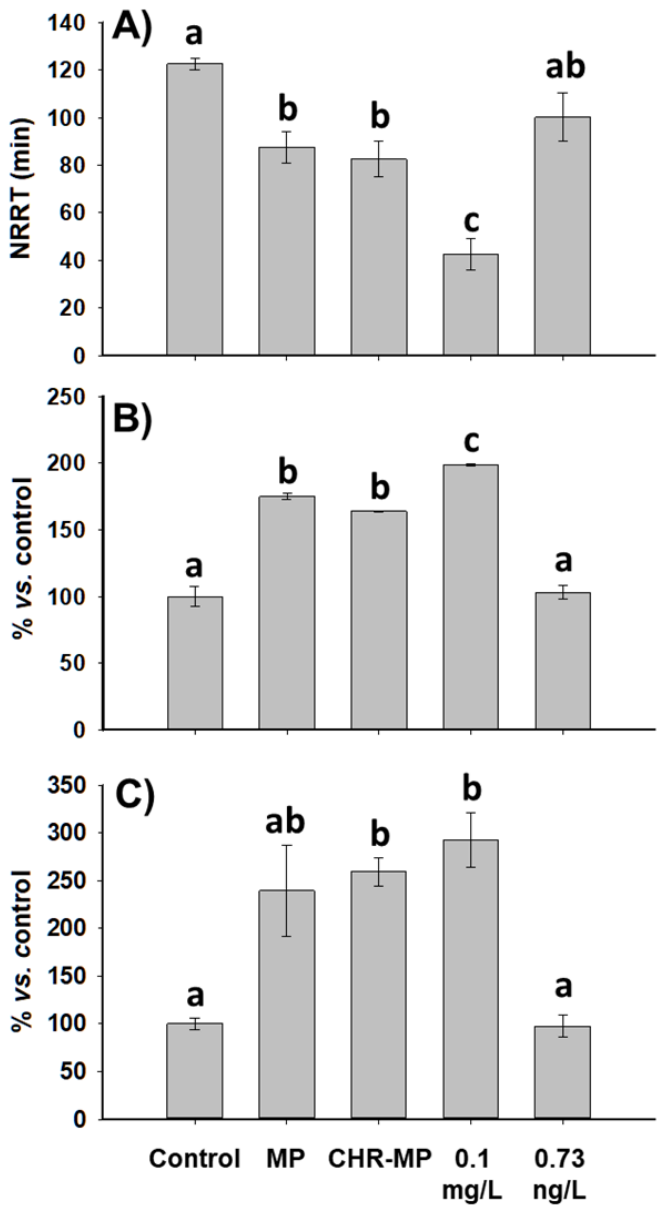
Figure 2. Lysosomal parameters (mean ± SEM, n = 3) analysed in mussels after 7 days of exposure to 5 × 10 3 units/L of polystyrene microplastics (MP) and chrysene-loaded microplastics (CHR-MP), 0.1 mg/L and 0.73 ng/L of freely dissolved CHR (without MP); ( A ), LMS assessed in mussel haemocytes; ( B , C ), lysosomal content of NL ( B ) and LF ( C ) in mussel digestive gland. Different letters denote statistically significant differences ( p < 0.05, ANOVA—Bonferroni post-hoc comparison) among treatments.